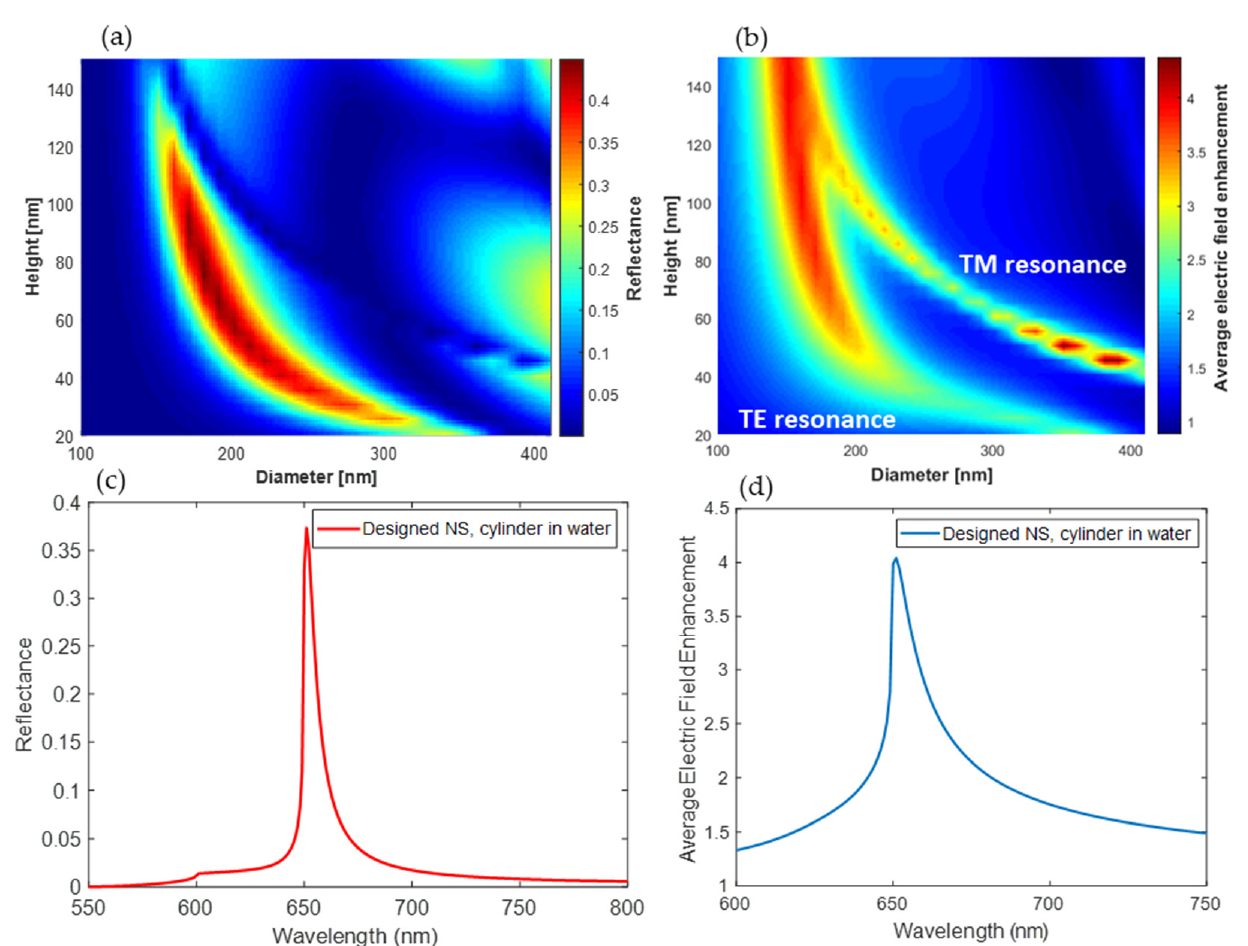
Figure 4. Optical properties of the inspected structures. ( a ) Computed reflectance and ( b ) average electric field enhancement E/E0 in a domain surrounding the nanoantenna as a function of the dimensions of the nanoantenna. ( c ) Computed reflectance and ( d ) average electric field enhancement spectra of the designed NS: 448 nm period array of a cylinder NS with the chosen parameters; diameter = 160 nm and height = 120 nm.